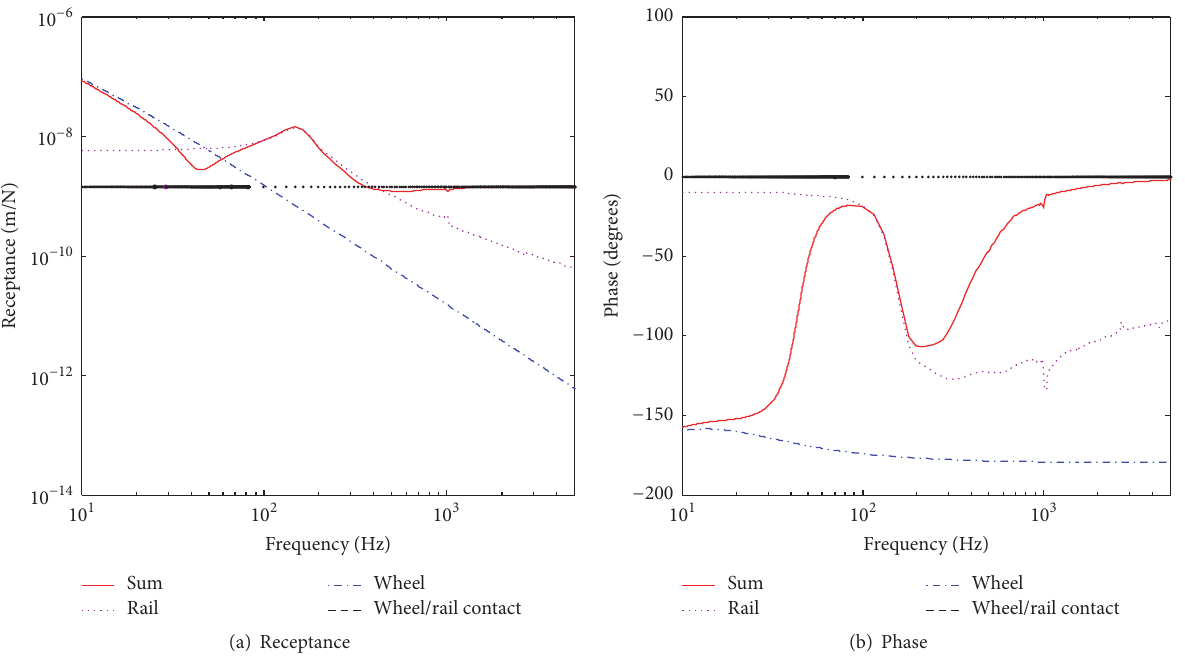
Figure 4: Displacement receptance contribution of the wheel/rail system.